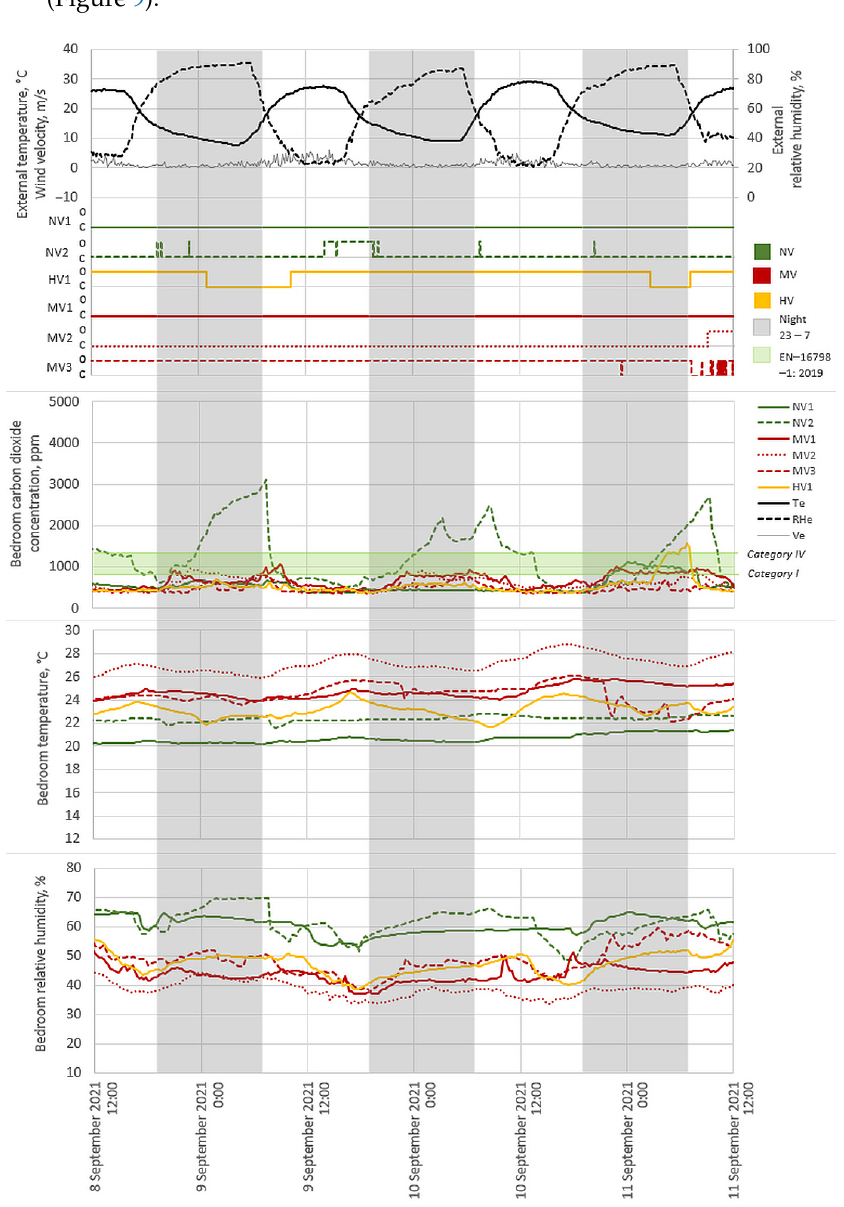
Figure 6. Detailed variability of the measured parameters over the period 8–11 September